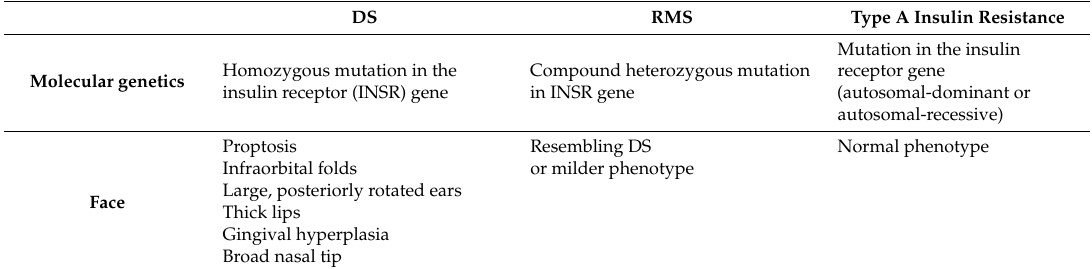
Table 1. Characteristic clinical features of subjects with Donohue syndrome (DS),